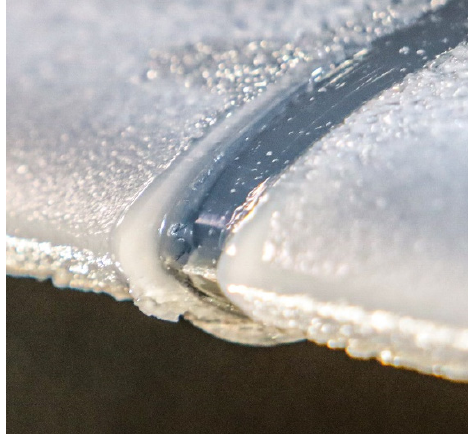
Figure 1. Chordwise cut into an ice shape that formed after 6 min of icing, shows how the entire leading-edge is covered by ice.